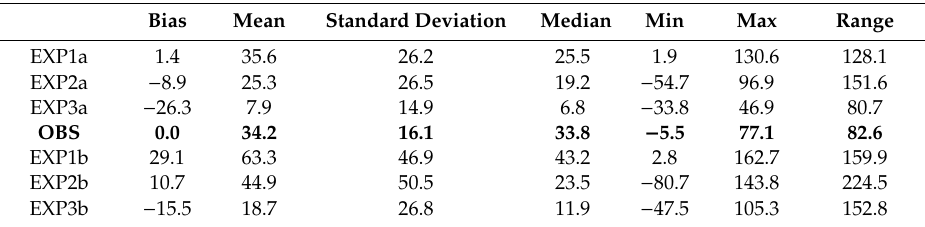
Table 6. SHF (W m − 2 ) simulated and observed at the CO station (data number